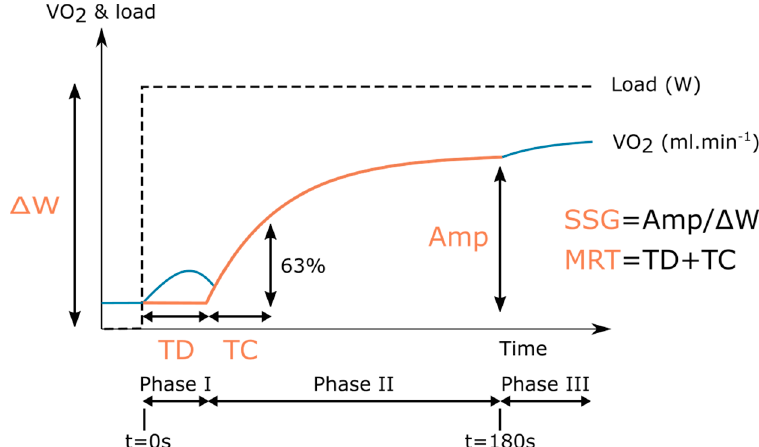
Figure 1. Graphical representation of the kinetic features that quantify the phase II response. The blue line represents the theoretical VO 2 response, the orange line shows the phase II contribution that should be modelled, the black dashed line visualises the load increase at t = 0 s. The blue and orange lines coincide during phase II. A slow component is visible in phase III. TD, Time delay; TC, time constant; MRT, mean response time; Amp, response amplitude; Δ W, the step increase in cycling load at t = 0 s; and SSG, steady state gain.